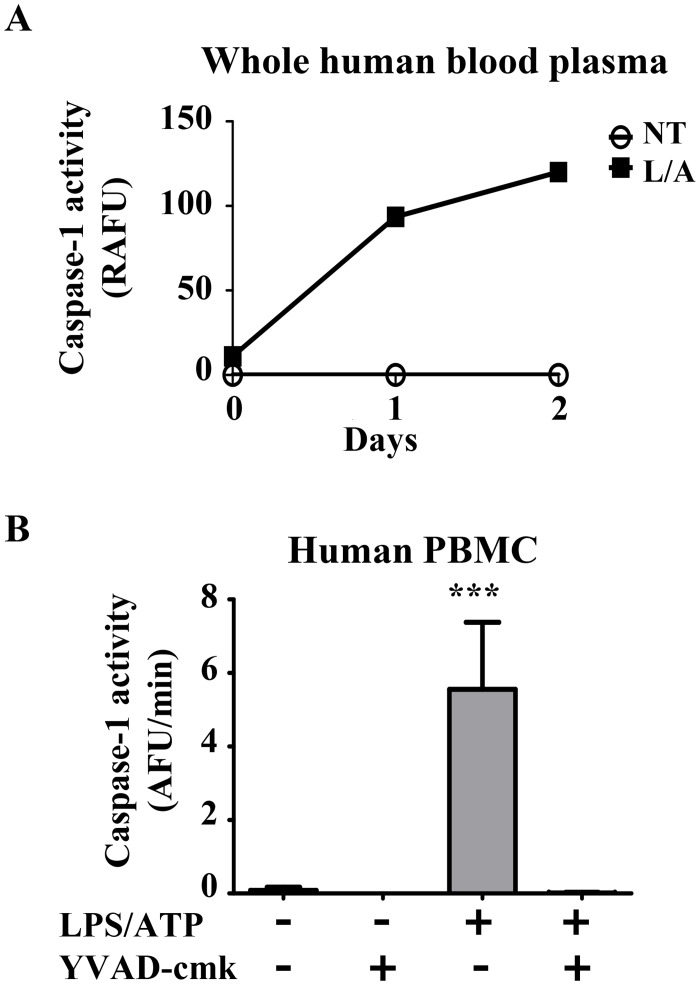
Caspase-1 activity detected extracellularly in whole human blood and purified human monocytes.A) Whole human blood (1 ml) from healthy donors was either left untreated (NT) or stimulated for 30 min with LPS (1 μg/ml) followed by an additional 30 min with ATP (5 mM) (L/A). Plasma was separated from blood cells and incubated with WEHD-afc (50 μM) for 2 days. Activity was calculated by subtracting background (relative absorbance fluorescence unit, RAFU). B) Human monocytes (peripheral blood mononuclear cells (PBMC)) were purified from healthy donors and treated at 2x107 monocytes/ml with LPS (1 μg/ml) and ATP (5 mM) as in (A). Supernatants were isolated and incubated with WEHD-afc (50 μM) in the presence or absence of YVAD-cmk (50 μM) to determine caspase-1 specific activity. Mean slopes over 2h are plotted from n = 2 independent experiments (A). Mean slopes over 2h are plotted with SEM from n = 5 independent experiments (B). ***: p<0.0001(ANOVA).